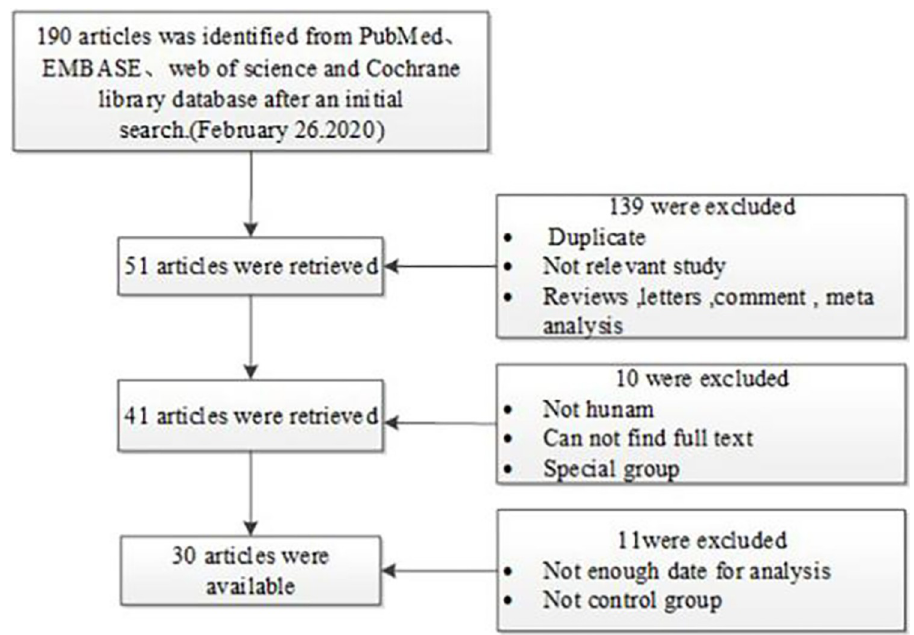
Fig 1. Flowchart showing the meta-analysis literature screening